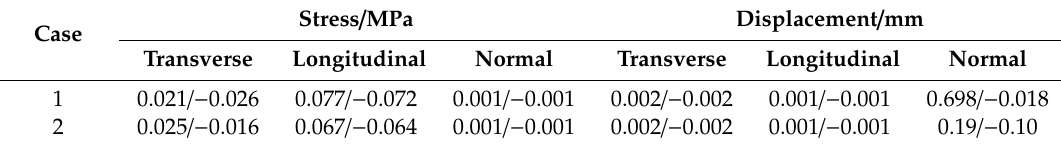
Figure 10. Interfacial damage contour under positive gradient temperature load. Table 7. Interfacial stress and displacement under positive gradient temperature load.